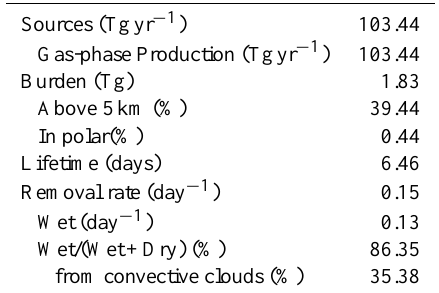
Table 4. Global budget for